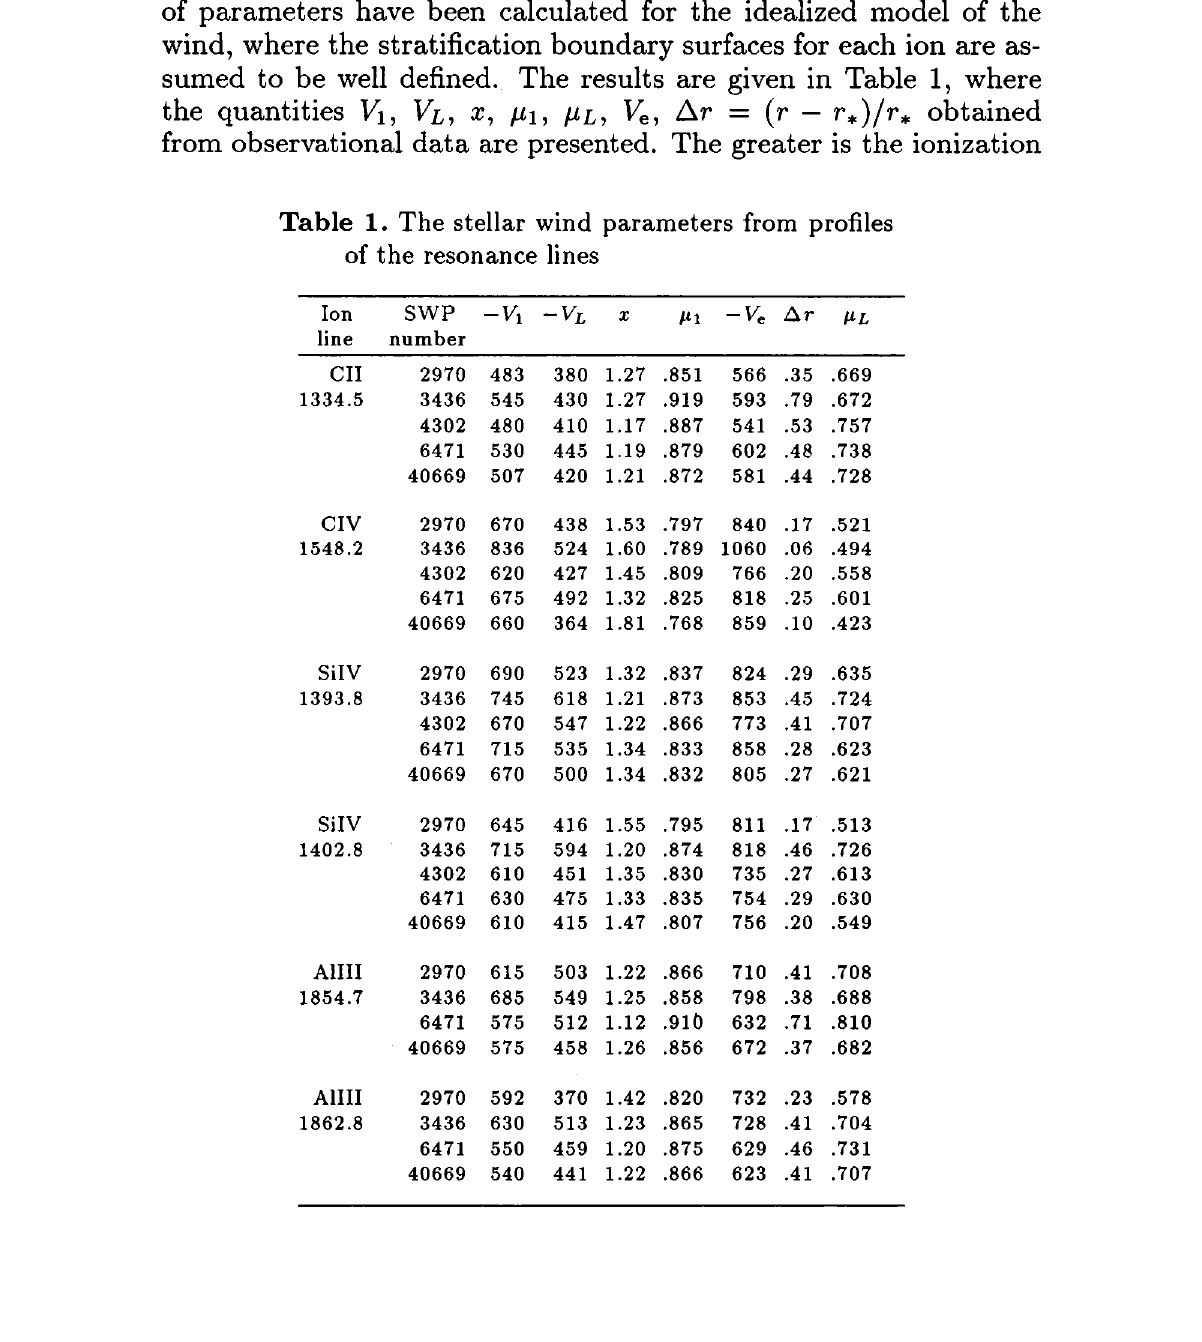
of the resonance